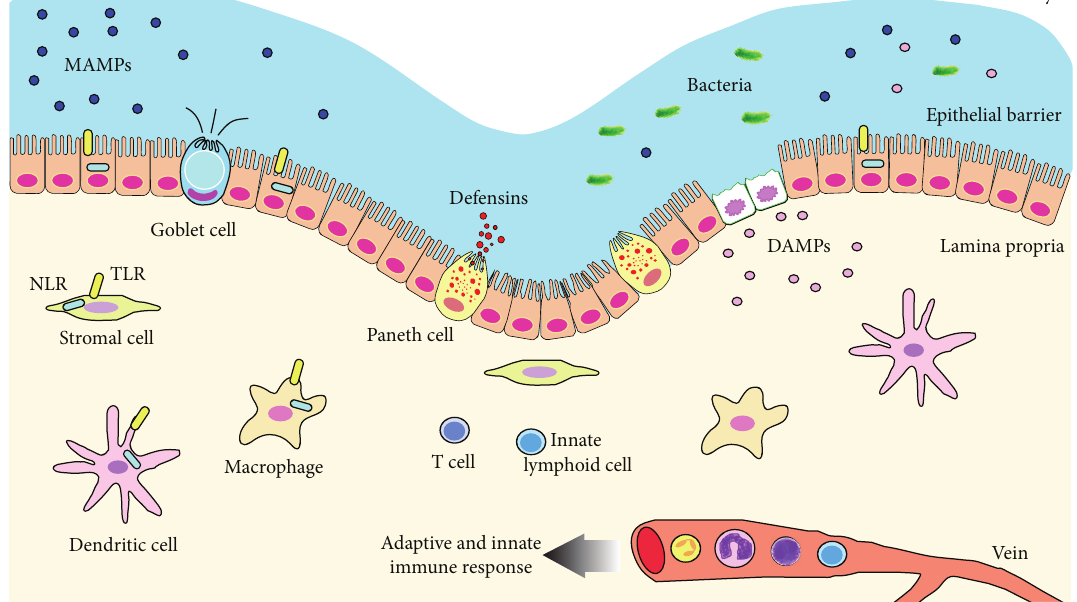
Figure 1: The mechanism of intestinal response against MAMPs and DAMPs in normal conditions. The epithelial barrier recognizes microbial-associated molecular patterns (MAMPs) by the presence of transmembrane TLRs and intracellular microbes and damage- associated molecular patterns (DAMPs), by the cytosolic NLRs. When invading the lamina propria, microorganisms can be recognized through the same mechanisms, by other cells such as dendritic cells, macrophages, lymphocytes, innate lymphoid cells, and stromal cells. The result of the activation of immune cells in the lamina propria and the degree of cell damage, caused by chemokines and cytokines, determine the feedback of the system. TLRs and NLRs drive the immune response and contribute to the maintenance of